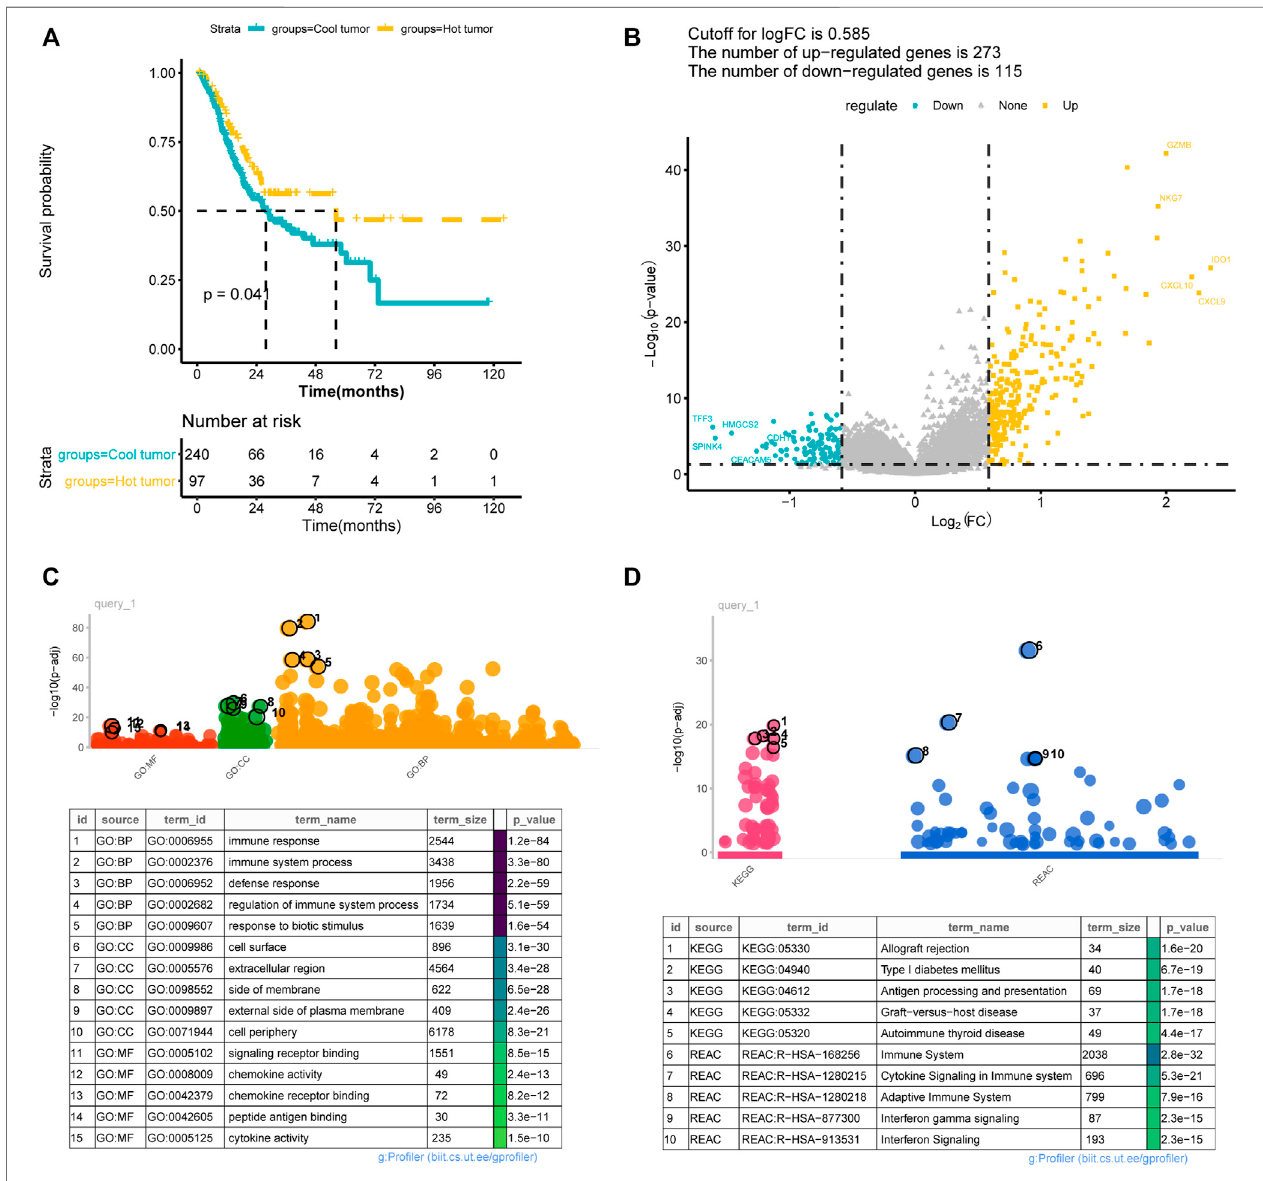
FIGURE 3 | Difference between immune hot and cold tumors. (A) Kaplan-Meier curves showed the survival differences between hot and cold tumors; (B) volcano plot showed the differentially expressed genes between hot and cold tumors. (C – D) The signi fi cantly enriched Gene Ontology annotations terms (C) and KEGG pathways (D) . BP, biological processes; CC, cellular component; MF, molecular